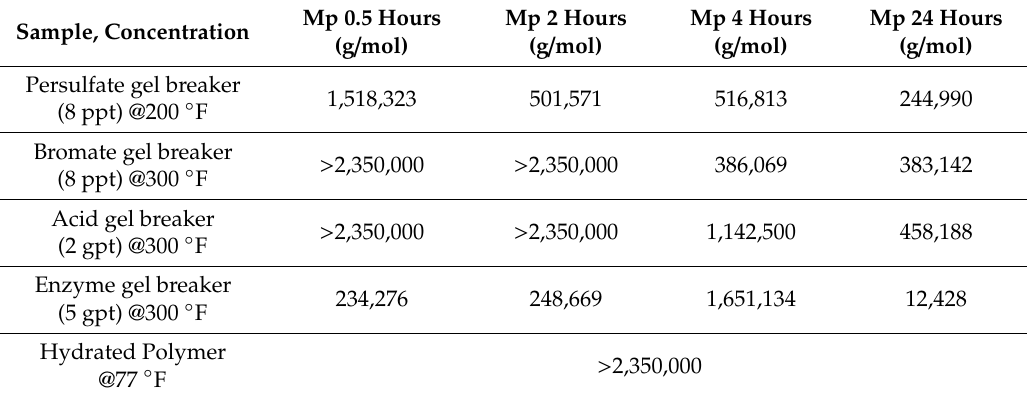
Figure 11. Peak molecular weight values for the 45 lb/1000 gal crosslinked fluid mixed with gel breakers at different time intervals at 200–300 °F. Table 3. Peak molecular weight values of fracturing fluid polymer with gel breaker samples.